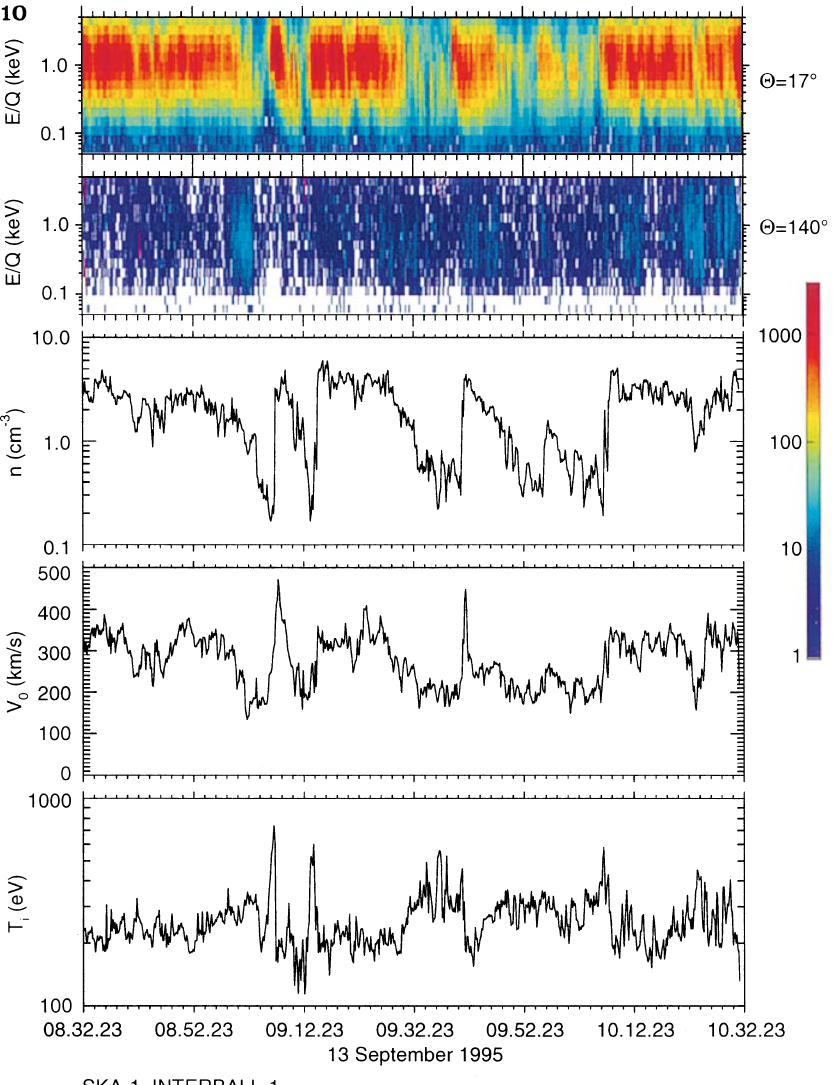
Fig. 10. The counting-rate spectra for two elevation cones of EU-1 during satellite pass in the vicinity of magnetopause on 13 September 1995 along with computed flow parameters, similar to format of